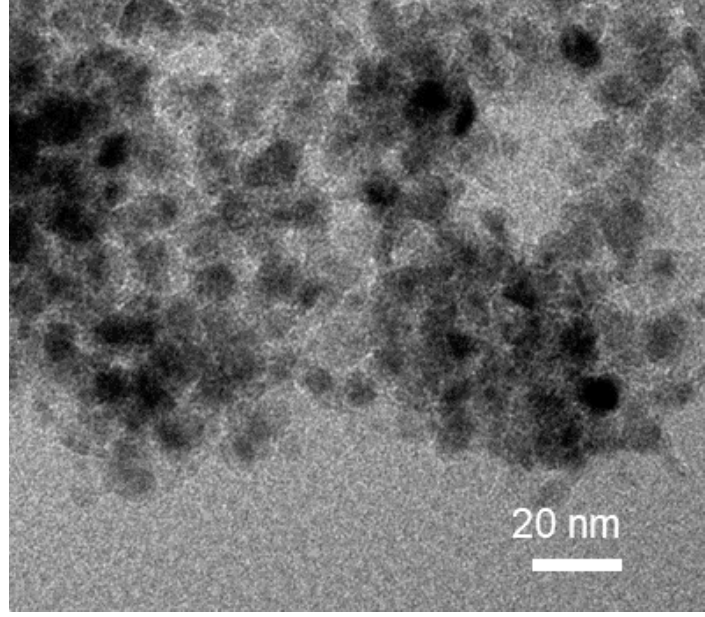
Figure 2. TEM image of reduced AMO-Ni 3 Al-CO 3 LDH solid.